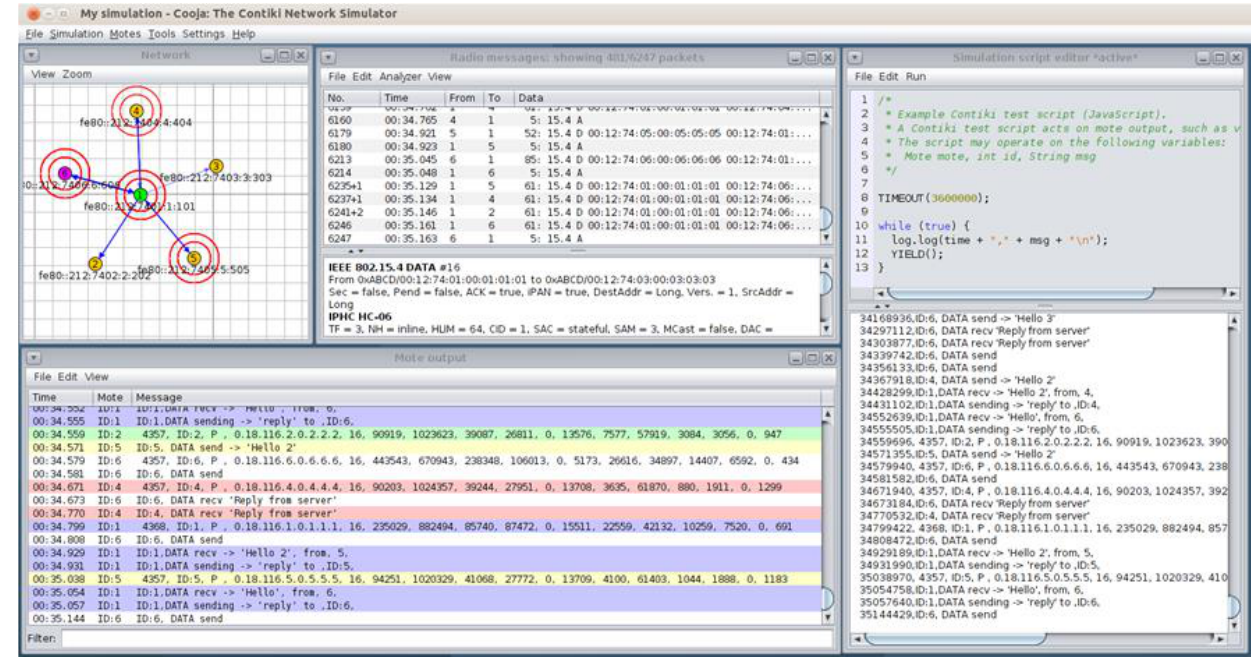
Figure 25. Cooja Simulator —motes’ outputs .